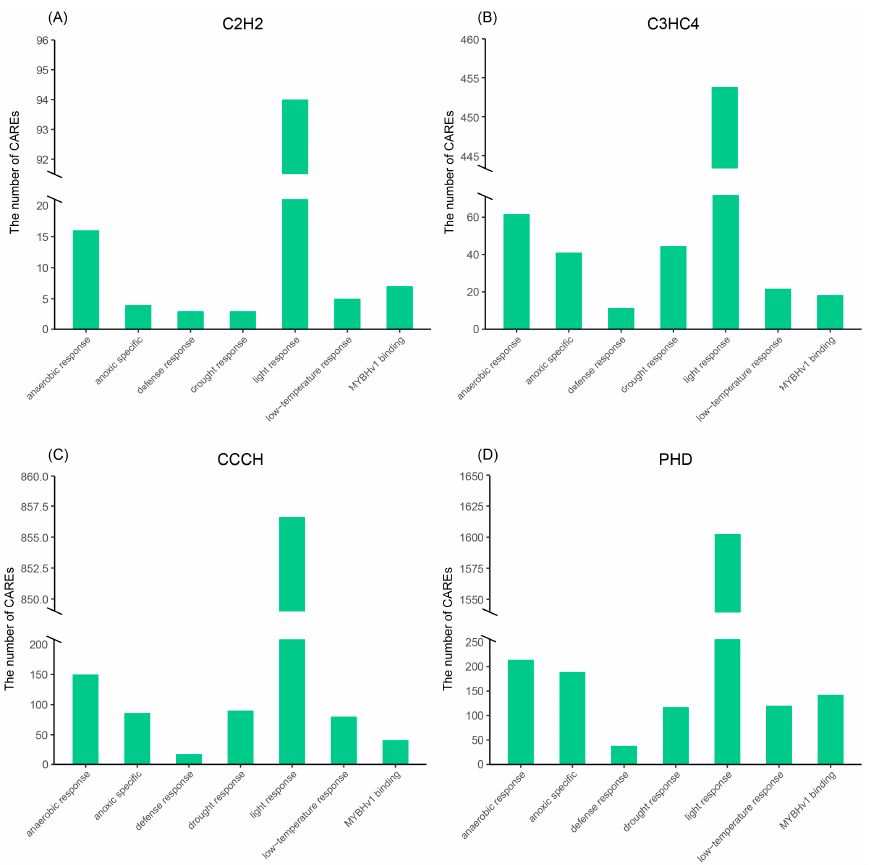
Figure 4. The most common cis -acting regulatory elements of the different TaZFP subfamilies. (A) TaC2H2 (B) TaC3H4 (C)TaCCCH (D)TaPHD. ( A ) TaC2H2 ( B ) TaC3H4 ( C ) TaCCCH ( D